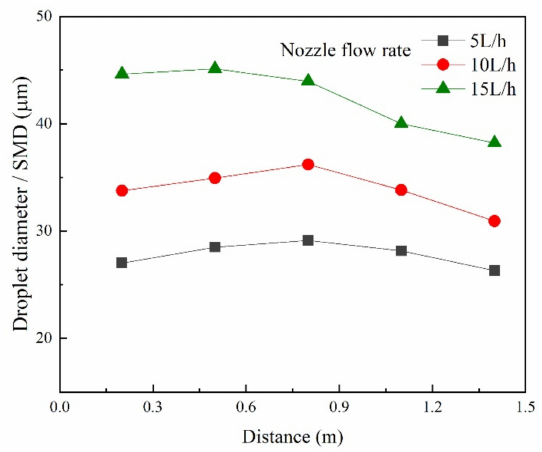
Figure 14. Effect of spray nozzle flow rate on SMD (P = 0.1 MPa, T = 70 °C).